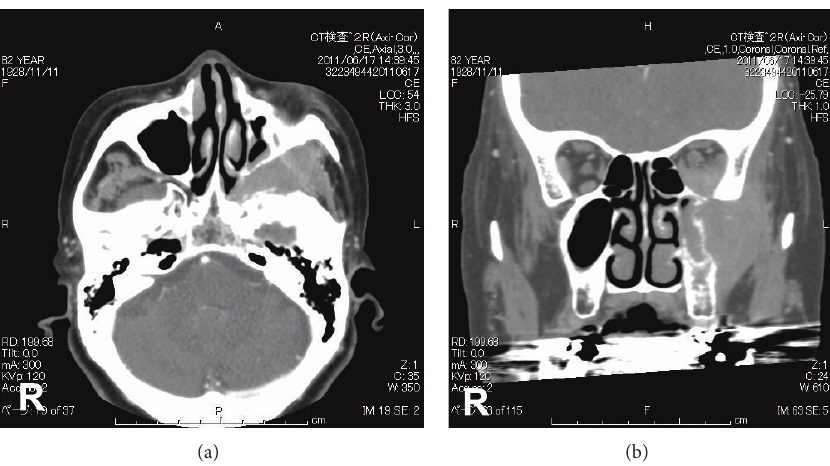
Figure 1: A neoplastic lesion with contrast effects and an indistinct boundary, which had invaded to the maxillary sinus and orbital cavity. The principal site of the lesion was the left pterygopalatine